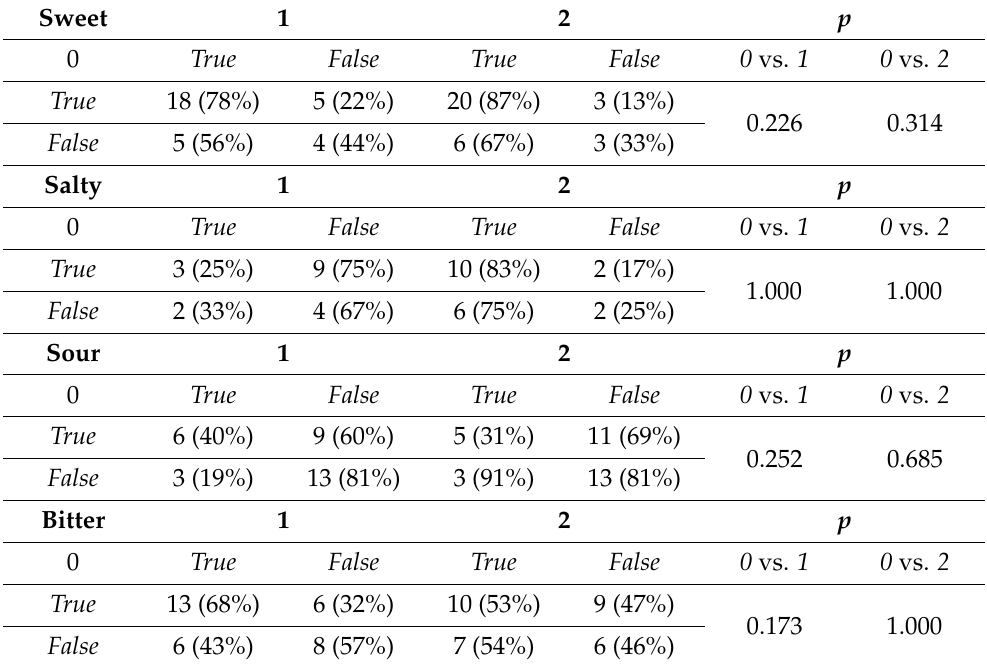
Table 7. The Control Side.